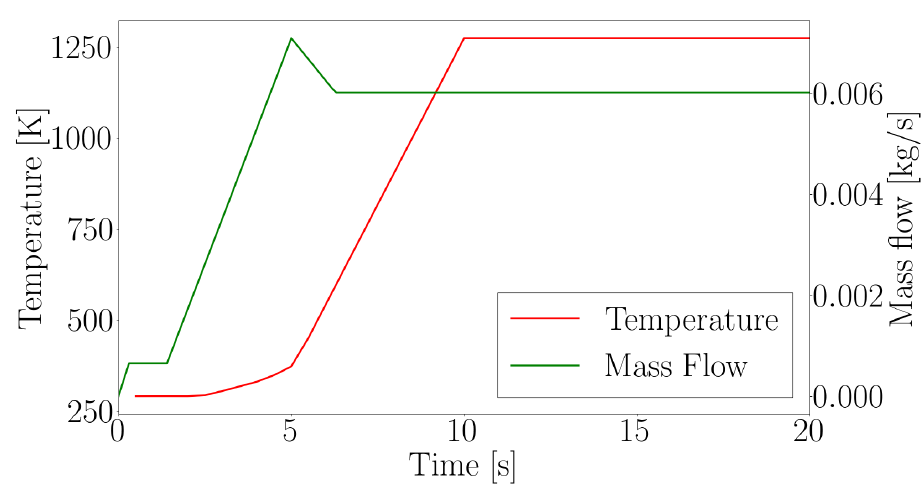
Figure 7. Assessment of the emissions’ abatement at the cold start: imposed exhaust gases’ tempera- ture and mass flow rate